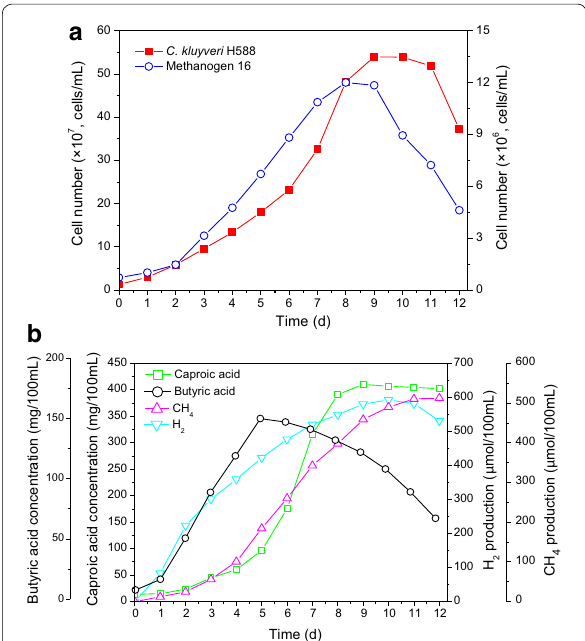
Fig. 2 Time courses of cell growth ( a ), caproic acid, butyric acid, H 2 and CH 4 production ( b ) for the co-culture fermentation